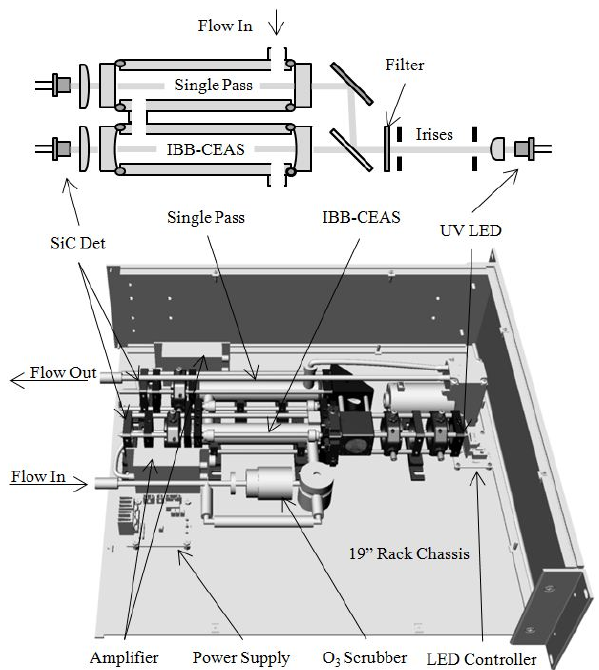
Fig. 1. Optical layout (top) and rendering (bottom) of simultaneous IBB-CEAS and single-pass ozone measurement system in a standard 19” rack-mount chassis.